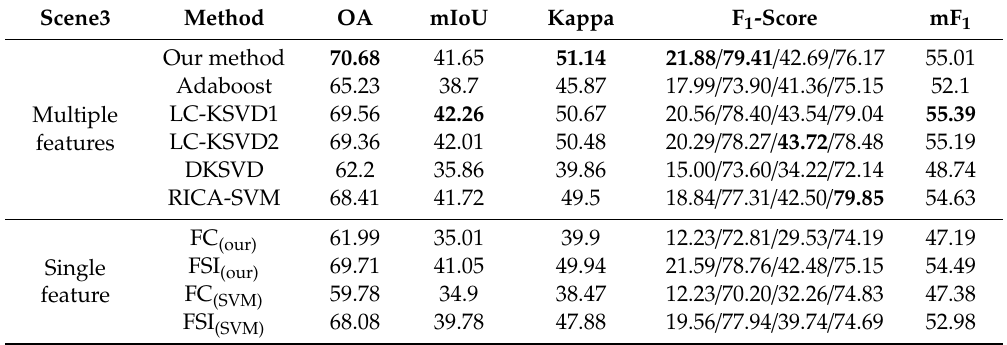
Table 5. Classification results of Scene3 (%). F 1 -score corresponds to the accuracy in terms of poles / buildings / cars / trees. Note the highest accuracy values are highlighted in bold.